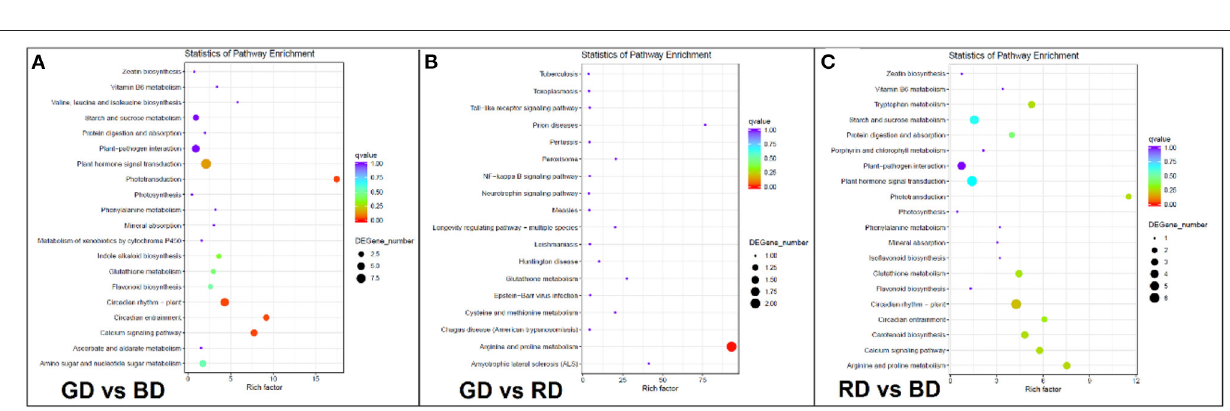
“circadian rhythm-plant” under RD vs. BD comparison ( Figure 6C ).